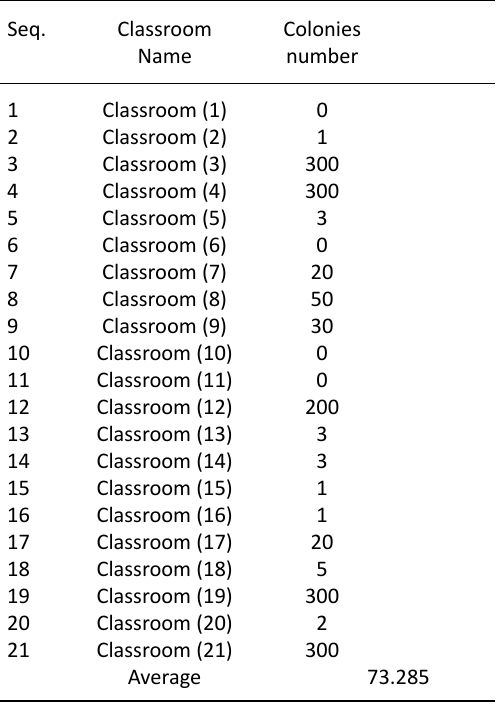
Table 1. Bacterial contamination of classroom doors handles Seq.